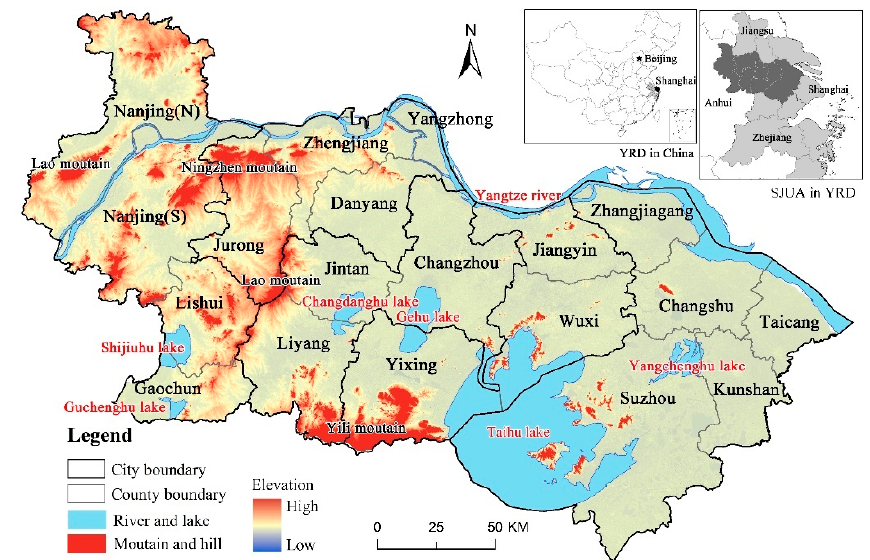
Figure 1. Flowchart of detection procedures.